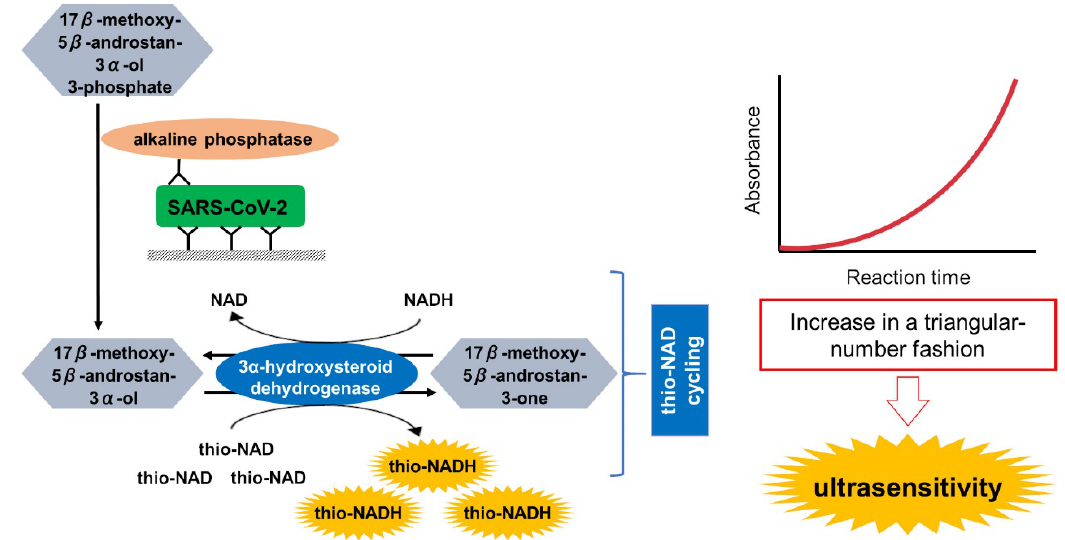
Figure 1. Principle of the ultrasensitive detection of SARS-CoV-2. The SARS-CoV-2 spike proteins were measured by a sandwich ELISA coupled with thio-NAD cycling using alkaline phosphatase, androsterone derivatives, and 3α - hydroxysteroid dehydrogenase (3α -HSD) and its coenzymes (NADH and thio-NAD). During this cycling reaction, thio-NADH accumulated in a triangular-number fashion. Accumulated thio-NADH was measured directly at an absorbance of 405 nm without interference from the other cofactors.